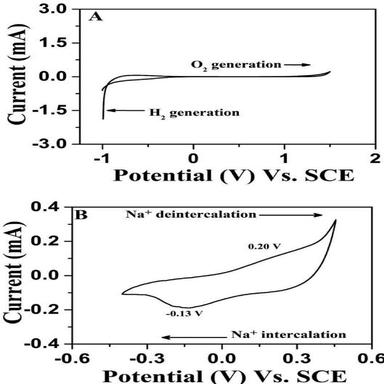
Cyclic voltammogram of, (A) Titanium mesh (Ti) in 5 M NaNO3 aqueous solution (Scan rate; 1.5 mV s 1 ) (B) Na3MnCO3PO4 electrode in 5 M NaNO3 aqueous solution (scan rate; 0.1 mV s 1 ).